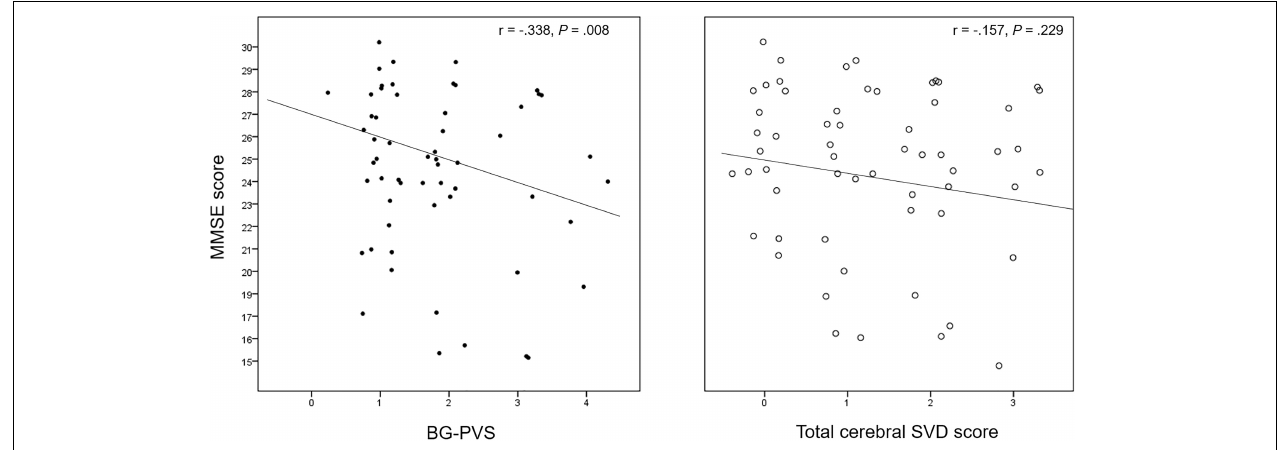
FIGURE 3 | Correlation plot between the BG-PVS severity and the total cerebral SVD score with the Mini-Mental State Examination (MMSE) score.